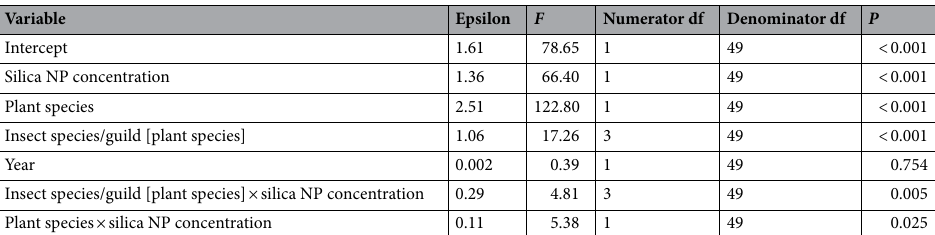
Table 1. MANOVA result on the reduction (%) of pest and predator insects on either faba bean or soybean plants in the field after 1–3 days of silica (SiO 2 ) nanoparticle (NP) application. Reduction measured on different dates were treated as repeated measures. Insect species/guild [plant species]: insect species (pests) or guild of predators nested within plant species.